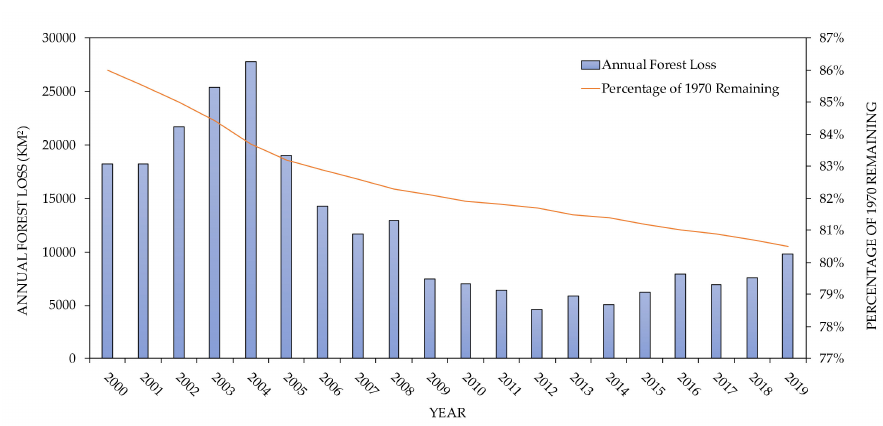
Figure 10. Forest change from 2000 to 2019.